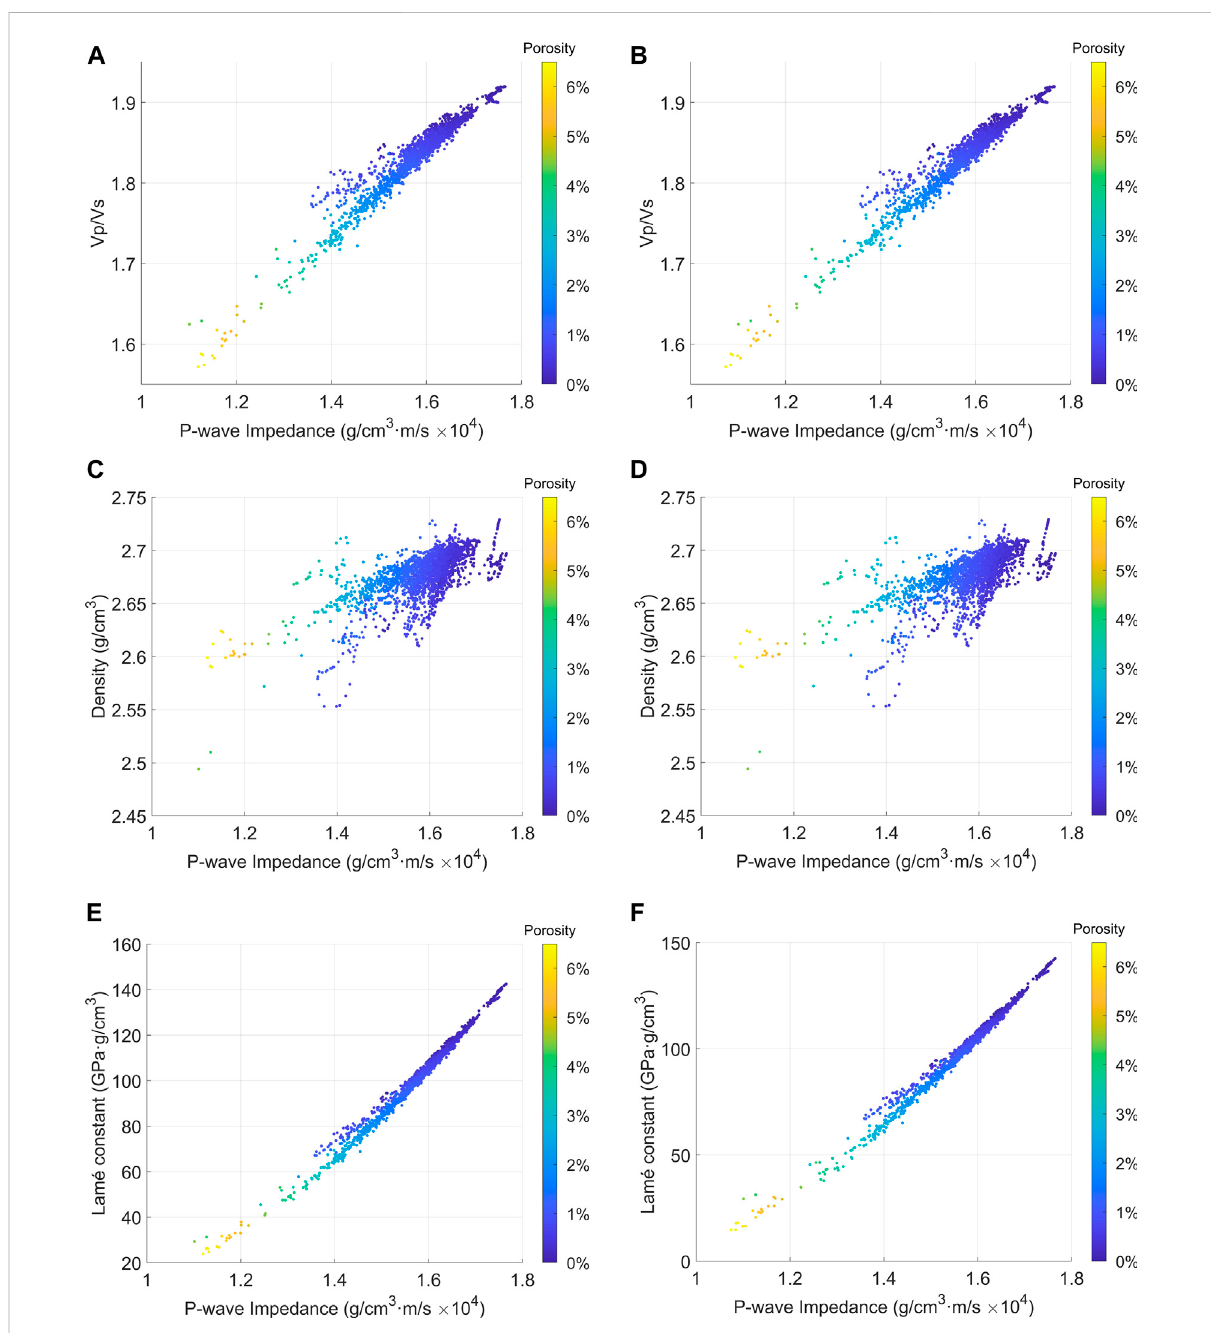
Crossplots of P-wave impedance, P-to-S-wave velocity ratio, and porosity (A) before and (B) after fl uid substitution. Crossplots of P-wave impedance, density,and porosity (C) beforeand (D) after fl uidsubstitution.CrossplotsofP-wave impedance, Laméconstant, andporosity (E) before and (F) after fl uid